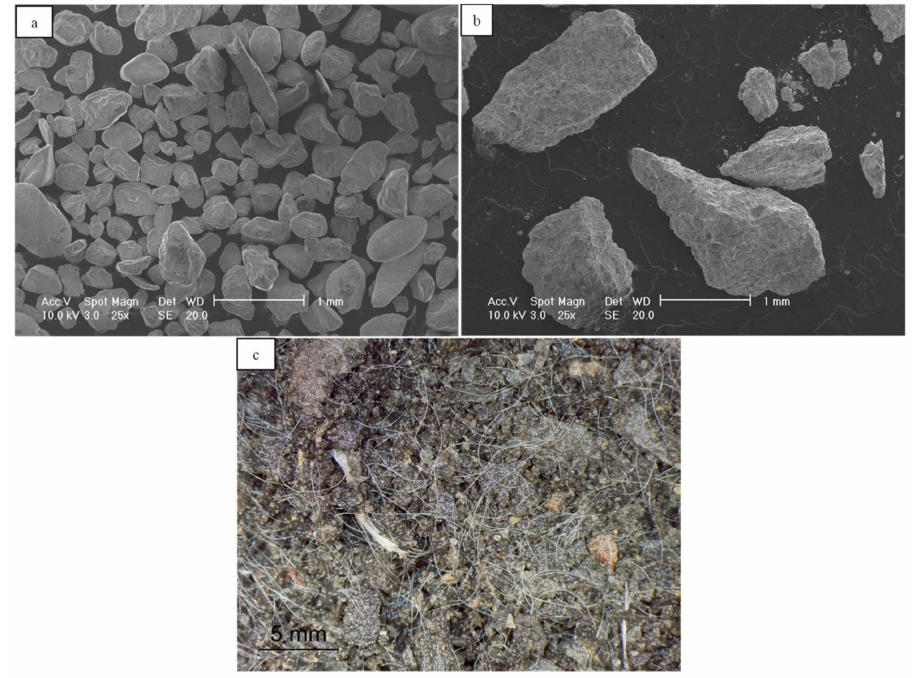
Figure 2. Scanning electron microscope (SEM) images of ( a ) Sydney sand, ( b ) Blue sand 1, and ( c ) Blue sand 1 mixed with polypropylene fibers. Table 1. Basic Properties of tested soils.